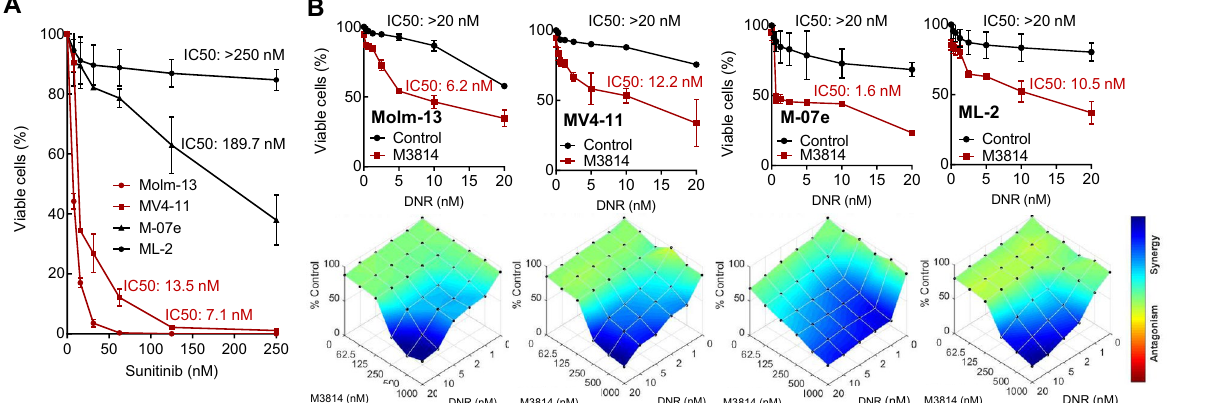
Figure 3. The potentiation of daunorubicin-mediated cell killing by M3814 is independent of FLT3 status. ( A ) Molm-13, MV4-11, ML-2 and M-07e cells were exposed to a dose range of sunitinib and the effect on their growth/viability was assessed by CellTiter-Glo after 3 d. IC50 values were calculated using GraphPad Prism. ( B ) Molm-13, MV4-11, ML-2 and M-07e cells were pre-treated with either DMSO or M3814 (300 nM) for 45 min and then with indicated concentrations of daunorubicin. Cell growth/viability was assessed by CellTiter-Glo on D 4 and IC50 values were calculated as above . Shown are daunorubicin dose–response curves (top) and overlays of Bliss synergy on relative viability landscapes (bottom). Bliss synergy was determined using Combenefit